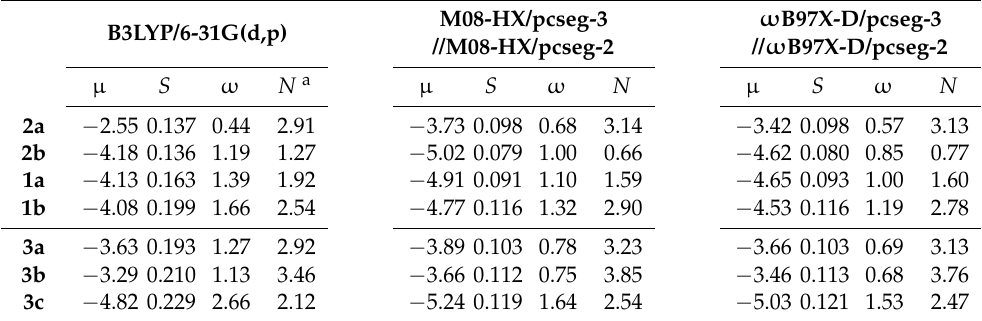
Table 2. Electron chemical potential ( µ ), hardness ( η ), softness ( S ), electrophilicity ( ω ), and nucle- ophilicity ( N ) of the investigated allenes and azides. All quantities are in given in